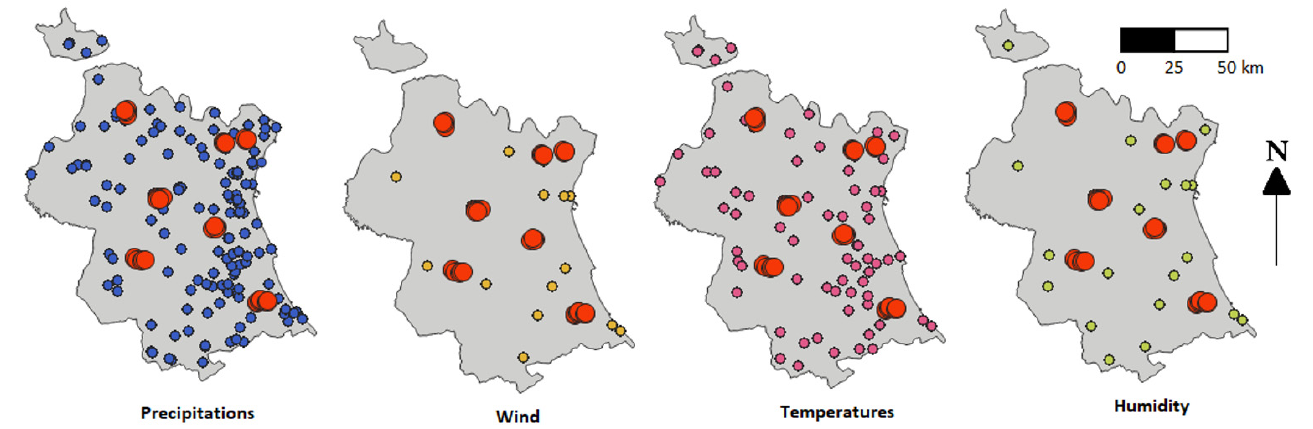
Figure 2. Spatial location of weather stations used to provide input data to the interpolation algorithm for the four meteorological variables registered. Red dots represent field sampling plots.